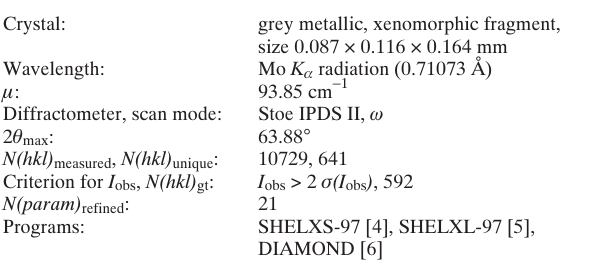
Table 1. Data collection and